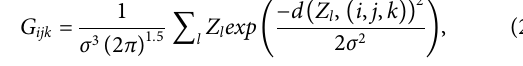
Frontiers in Materials |